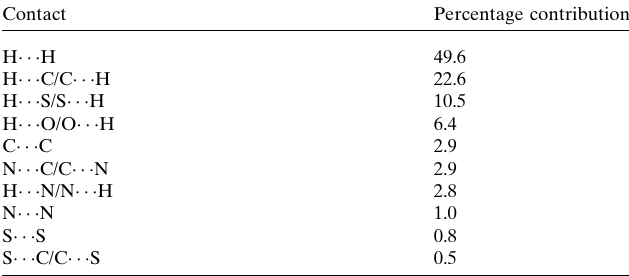
Two views of the Hirshfeld surface mapped for (I) over ( a ) d norm in the range (cid:3) 0.490 to +1.188 arbitrary units. C6—H6 (cid:4) (cid:4) (cid:4) (cid:2) (C12–C17; Cg 2) interactions are shown as faint surface in Fig. 5( a ) and as two distinctive red spots on the d norm orange ‘potholes’ on the shape-index-mapped over Hirshfeld surface in Fig. 5( b ). It is noted that the phenyl-C4— H4 (cid:4) (cid:4) (cid:4) (cid:2) (C12–C17, Cg 2) interaction, Table 1, was not mani-